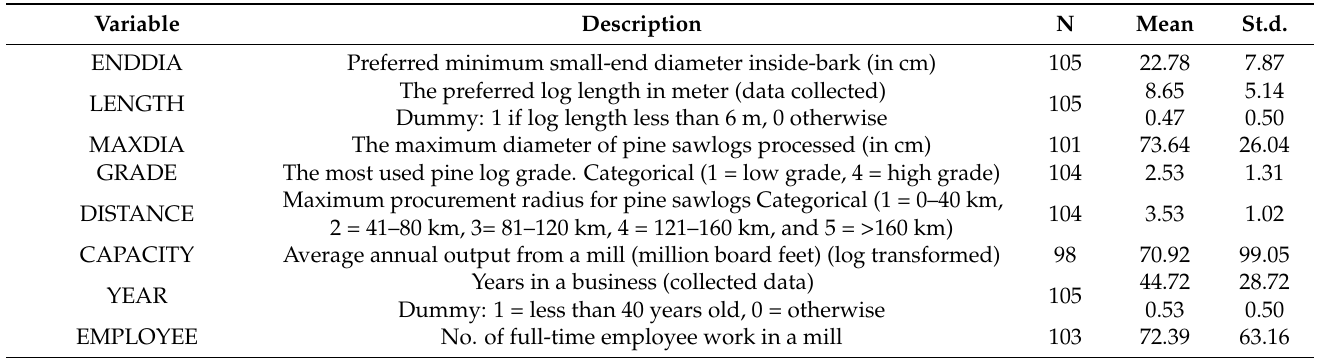
Table 1. Description of variables used in estimating sawmill willingness to pay (WTP) a price premium for higher quality pine sawtimber grown to an extended rotation across the southeastern United States based on a 2018 mail